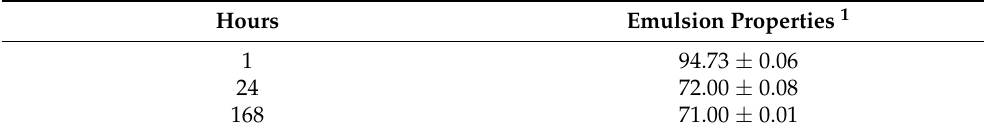
Table 2. Emulsion properties of KWSP